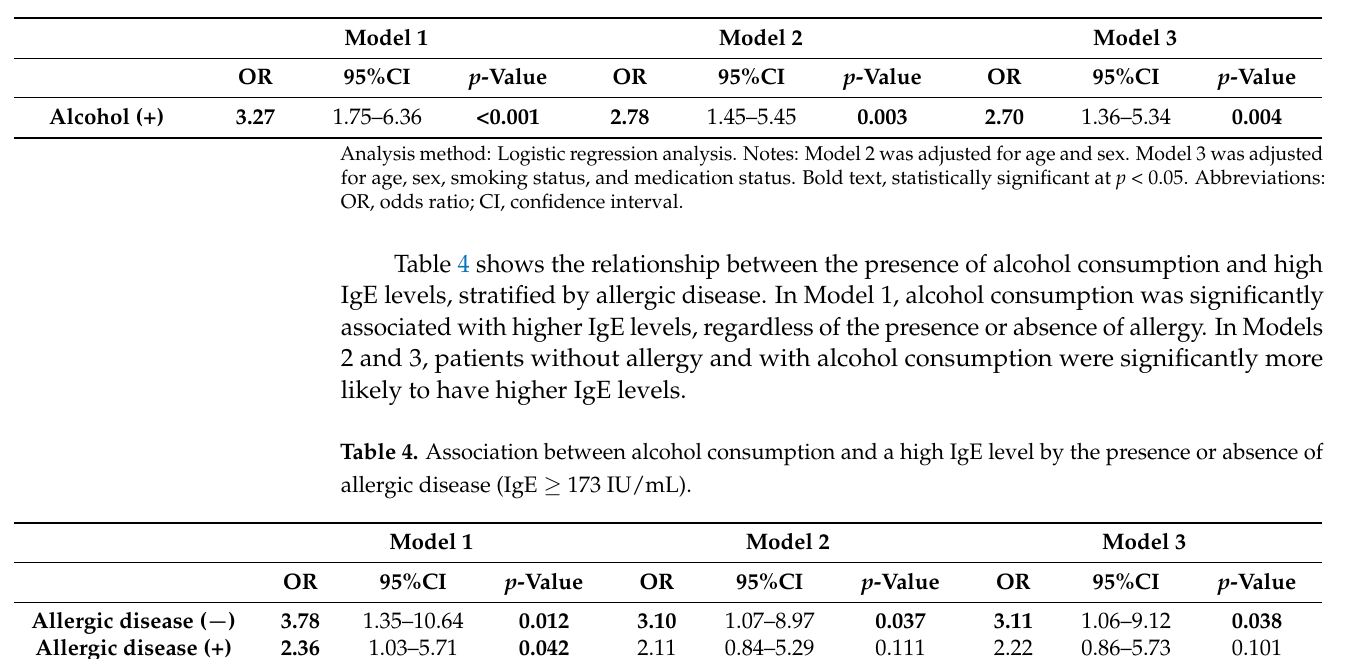
Table 3. Association between alcohol consumption and a high IgE level ( ≥ 173 IU/mL).